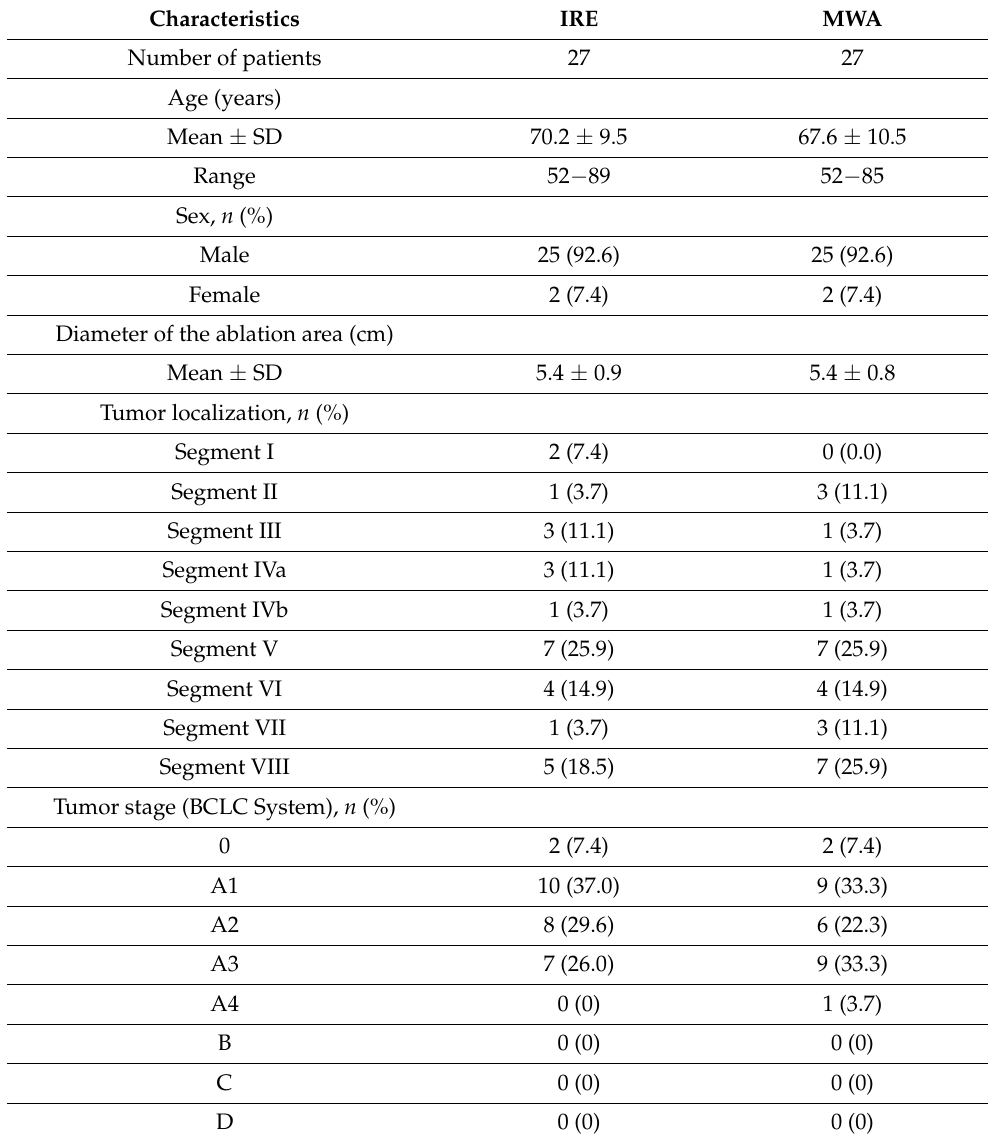
Table 1. Patient and disease